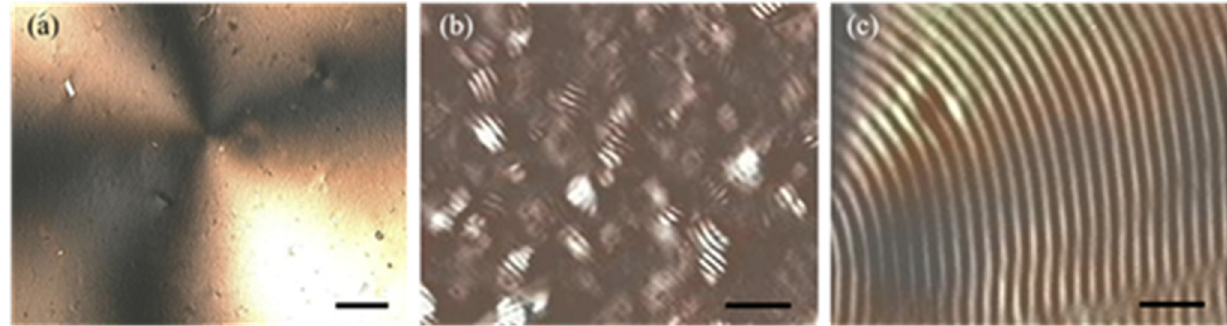
Figure 2. Optical microscopy images of CNC suspensions seen through crossed linear polarizers with a storage time of: ( a ) no storage, ( b ) 90 days, and ( c ) the same sample as in ( b ) but 11 days later. The scale bars are 400, 100, and 20 μ m, respectively.